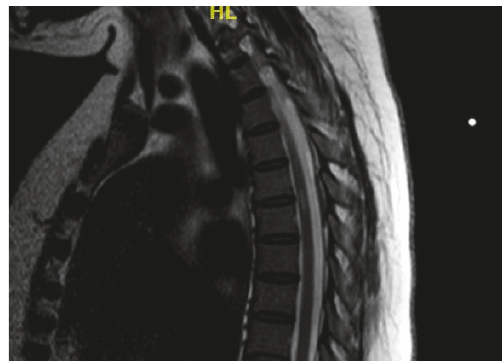
Figure 2: MRI T2 sagittal view of epidural blood collection which has decreased in size to 2-3mm.